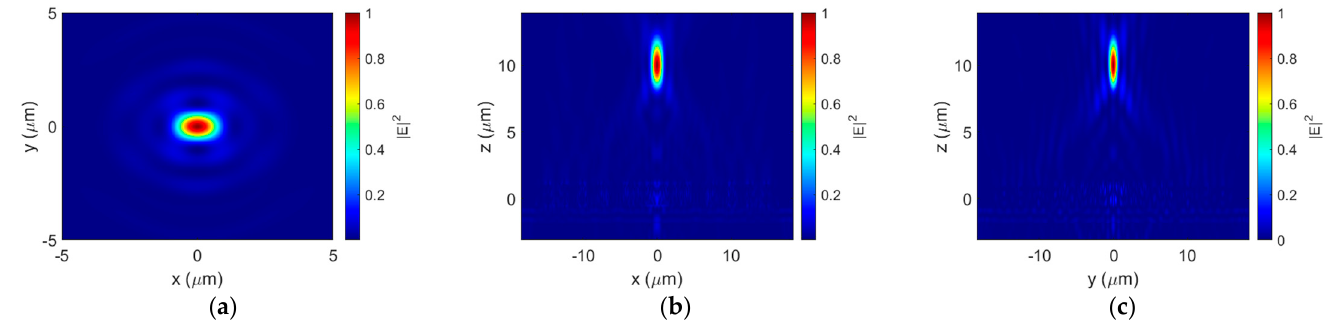
Figure 11. Normalized electric field intensity distributions: ( a ) at the focal plane, ( b ) of the propagation cross-section taken along the major axis of the focal spot, and ( c ) of the propagation cross-section taken along the minor axis of the focal spot.